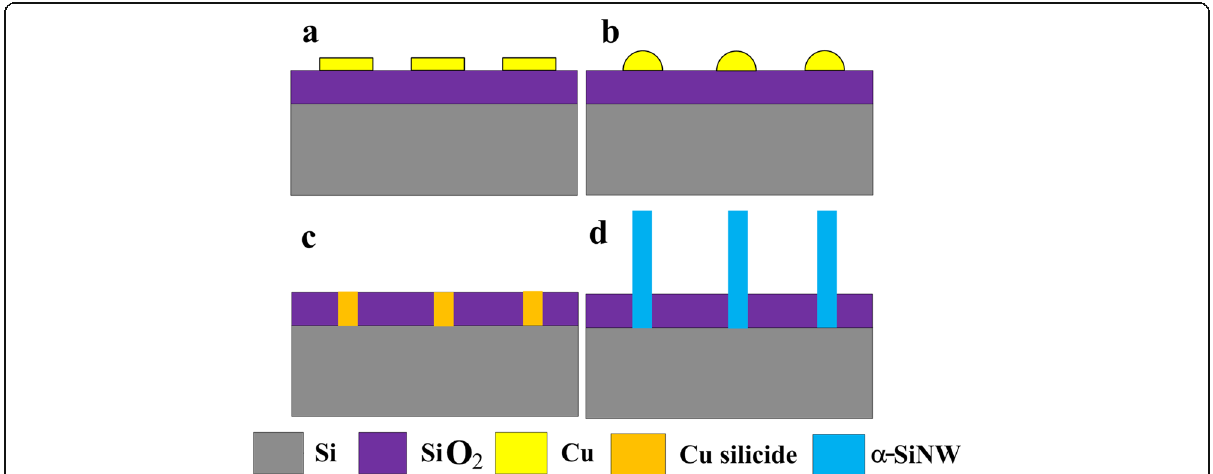
Fig. 6 Schematic illustration of α -SiNW growth. During the annealing process, Cu patterns ( a ) dewet to the center of the pattern ( b ), and react with SiO 2 to form Cu silicide ( c ). Then, Si atoms permeate into the Cu silicide. During this process, the different diffusion speed of Si atoms in the substrate which caused by the defect of substrate may induce the Si gap formation. When the dissolving Si atoms in silicide reached saturation, Si starts to precipitate to synthesis α -SiNWs ( d )